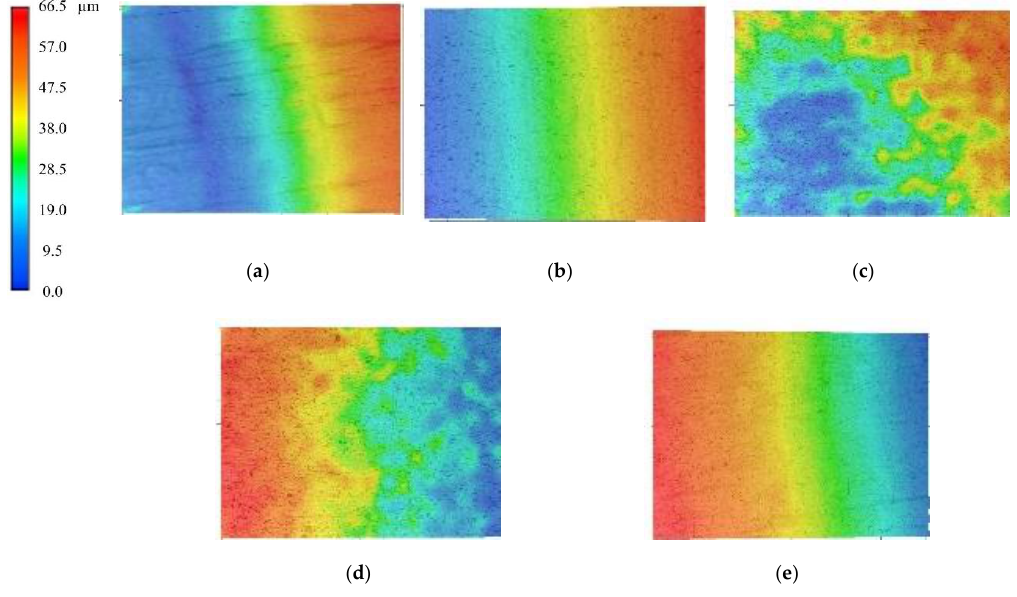
Figure 23. The surface appearance of five regions after 3 h processing: ( a ) L1, ( b ) L2, ( c ) L3, ( d ) L4, ( e ) L5.